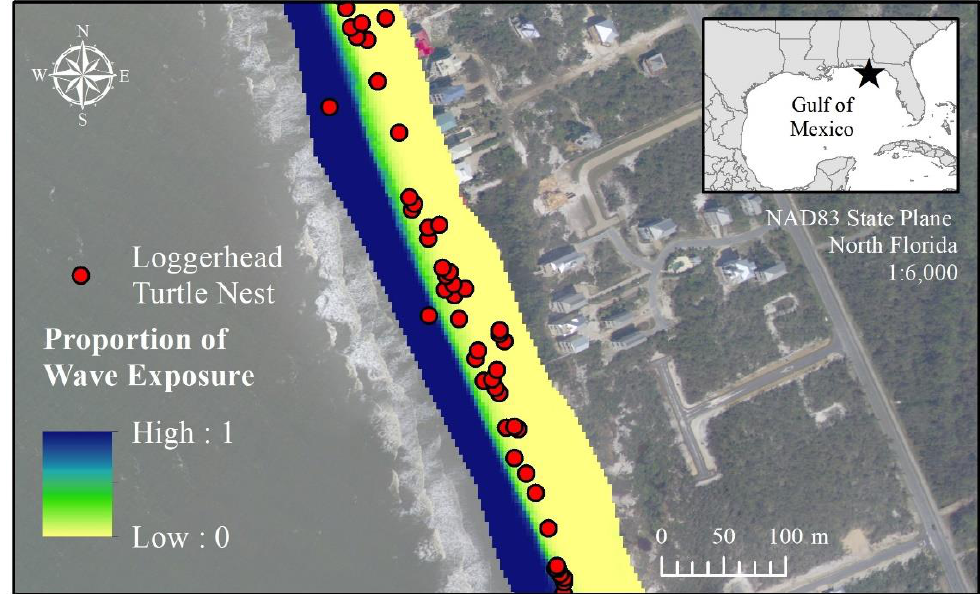
Figure 3. Proportion of wave exposure along a stretch of the Saint Joseph Peninsula shoreline from 2016 to 2019. Loggerhead sea turtle nests laid during this time were typically above the most frequently exposed portions of the beach.